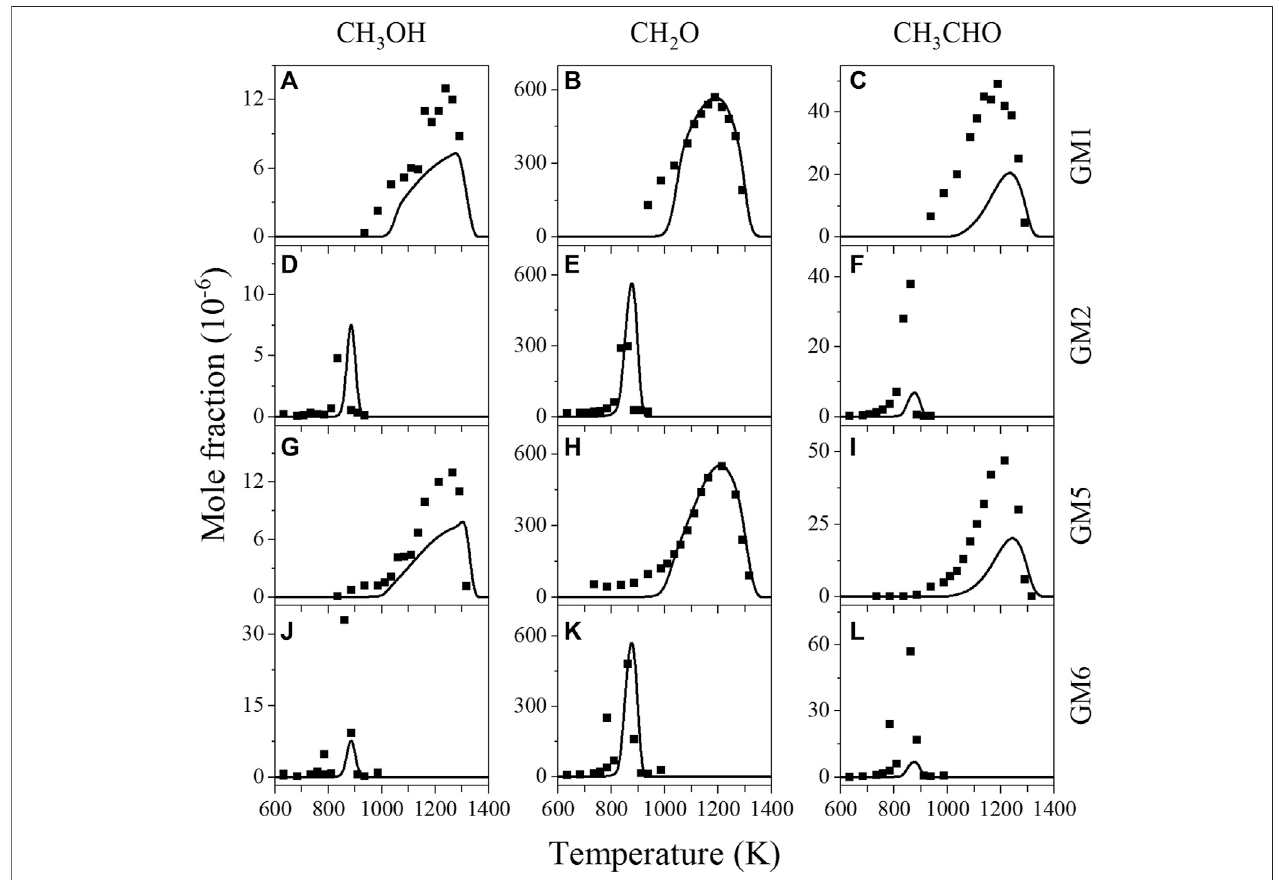
FIGURE 9 | Experimental (symbols) and simulated (lines) mole fraction pro fi les of methanol (CH 3 OH), formaldehyde (CH 2 O) and acetaldehyde (CH 3 CHO) in the oxidation of GM1, GM2, GM5 and GM6.